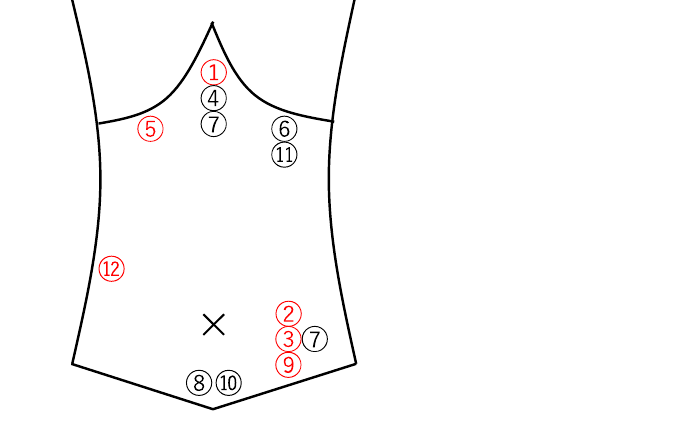
Figure 2. The sites of abdominal pain. (Red number indicate abdominal wall pain). The numbers indicated the case number in Table 1.